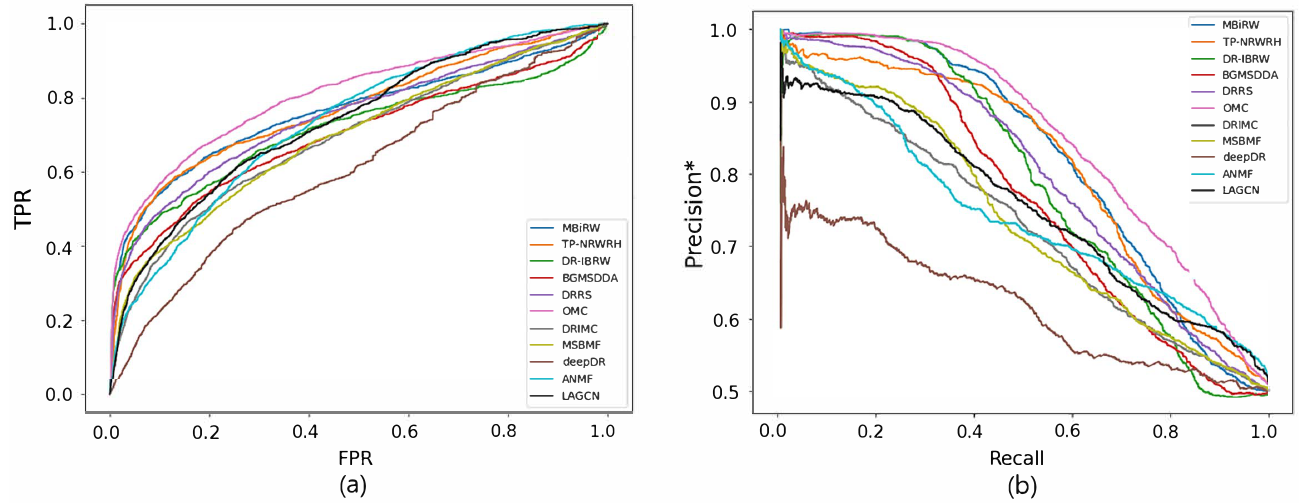
Figure 5. ROC curve ( a ) and precision*-recall curve ( b ) of drug-disease association prediction results for new diseases with